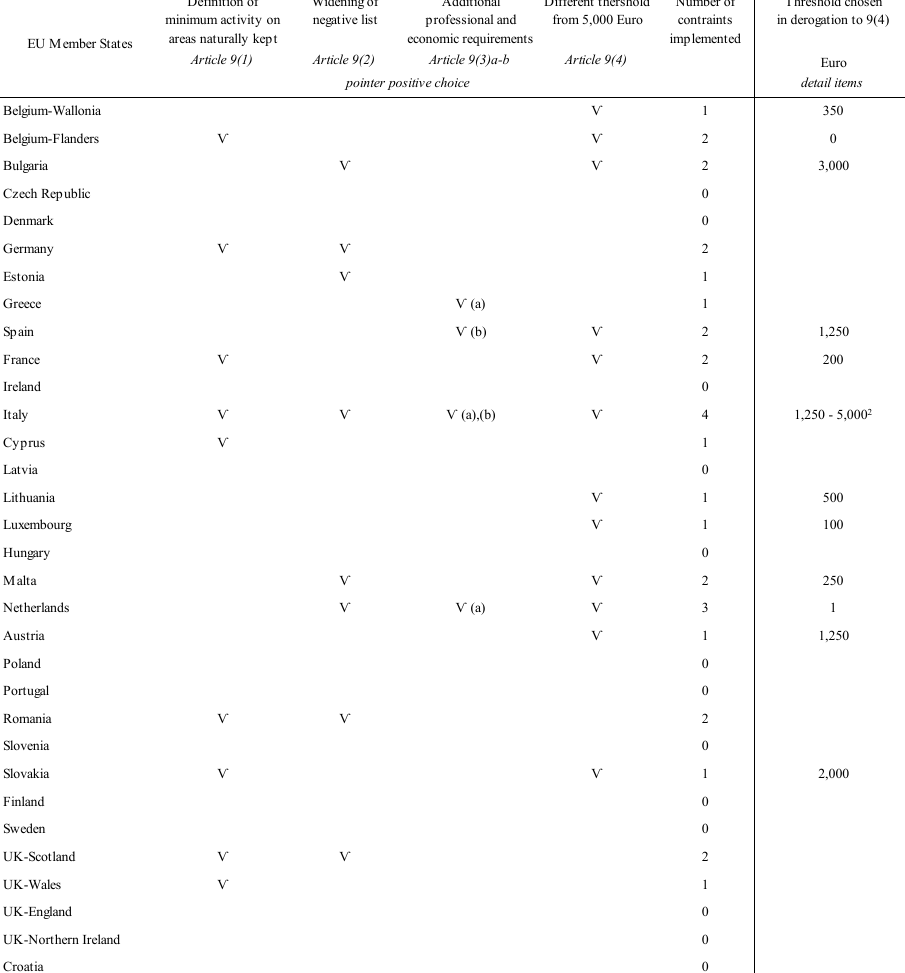
Table 3. The choices of the Member States under the legislative framework on the “active farmer” 1